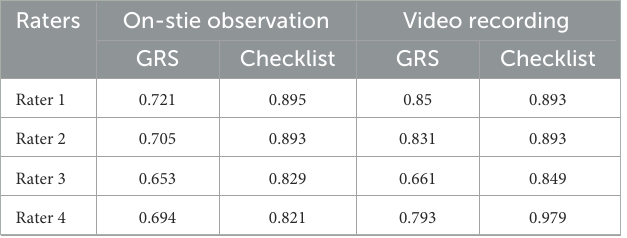
TABLE 4 Rater reliability (Cronbach’s α coefficient) of on-site observation and video recording-based scores by GRS and checklist.